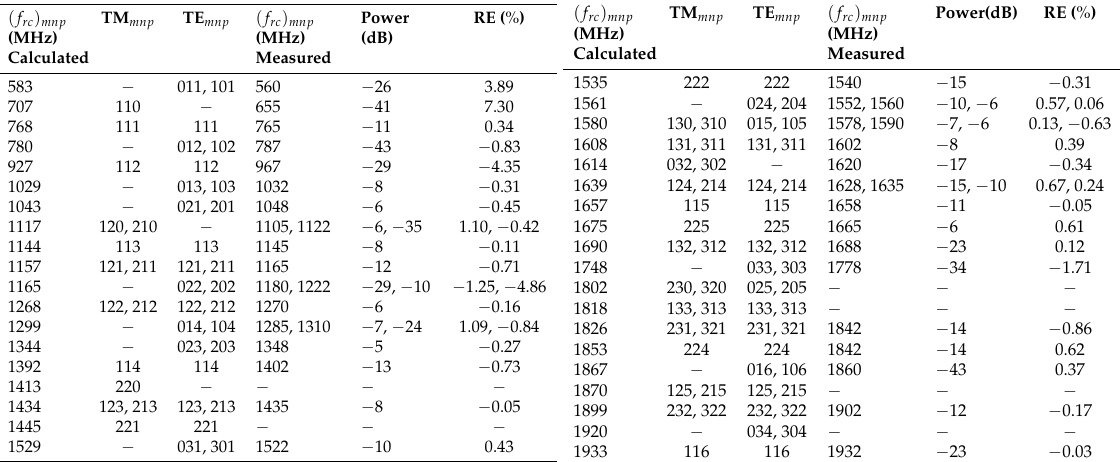
Table 3. Frequency resonances for a 30 × 30 × 50 cm cavity in 500–2000